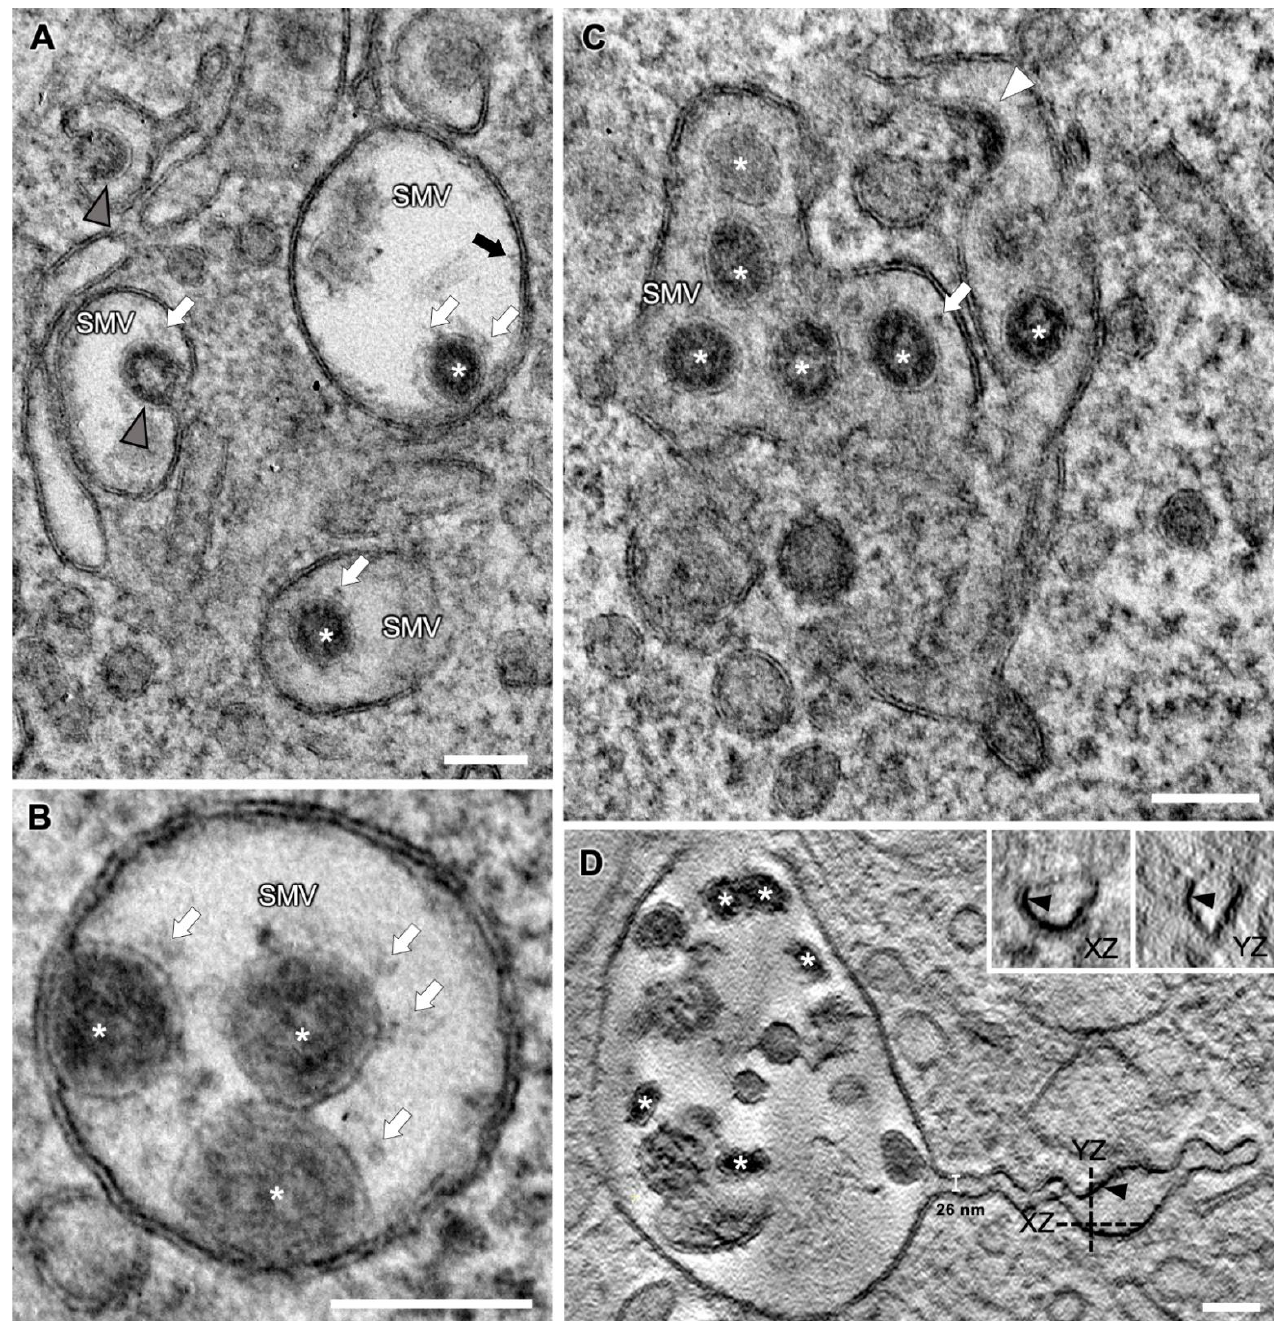
Figure 3. Different appearances of SARS-CoV-2 virion-containing SMVs at 24 hpi. ( A – C ) Various SMVs with beginning (white arrowhead) and advanced (grey arrowheads) virion budding stages, and nascent virions (white asterisks). Note the viral S proteins on the virion envelopes (white arrows) and the protein densities on the inner leaflet of the SMV membrane (black arrow). ( D ) Virtual section through a STEM tomogram of an SMV with a tubular extension containing numerous virions (white asterisks). Dashed lines indicate the position and direction of the virtual XZ and YZ sections shown in the insets. Black arrowheads mark a fine seam of electron-dense material at the inner membrane leaflet. Scale bars, 100 nm.